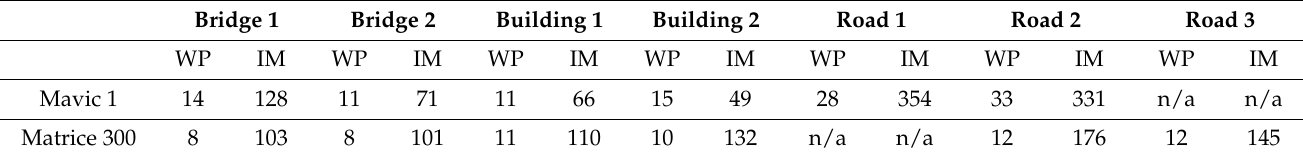
Table 3. Number of baseline waypoints (WP) and images (IM) by feature and platform; n/a = not applicable. Not applicable (n/a) indicates the platform was not flown for that feature; this occurred due to pedestrian and vehicle traffic safety